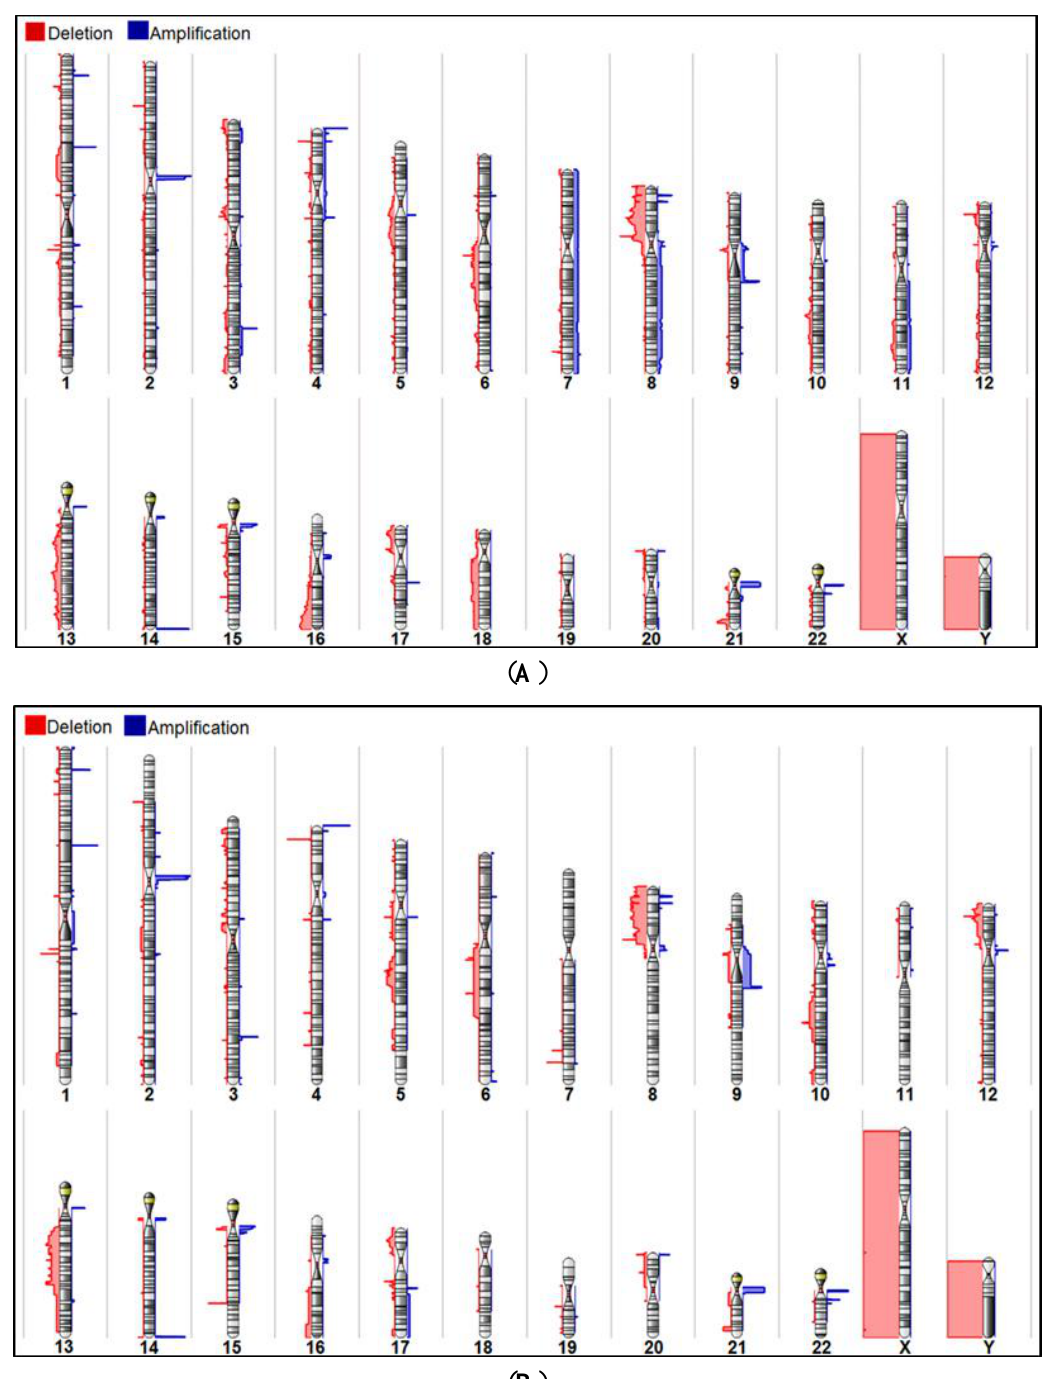
Figure 2. Summary of all tumors in a karyoview. ( A ) Multifocal prostate cancers; ( B ) Unifocal prostate cancers. Regions of blue and red are specific to regions of gains and losses,